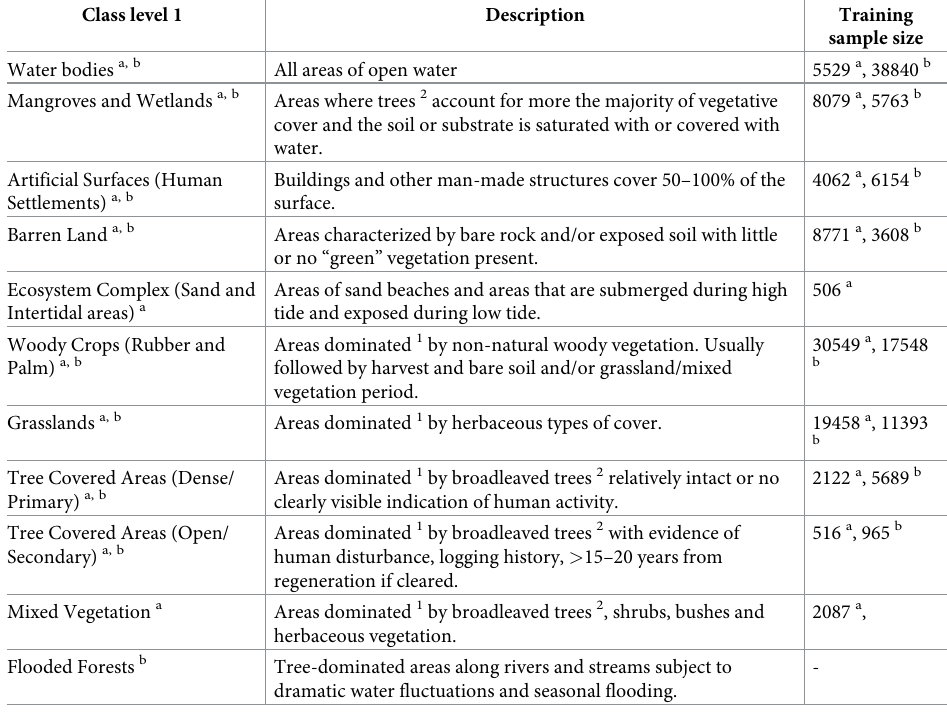
Table 2. Class definitions and training data for the Liberia and Gabon land cover